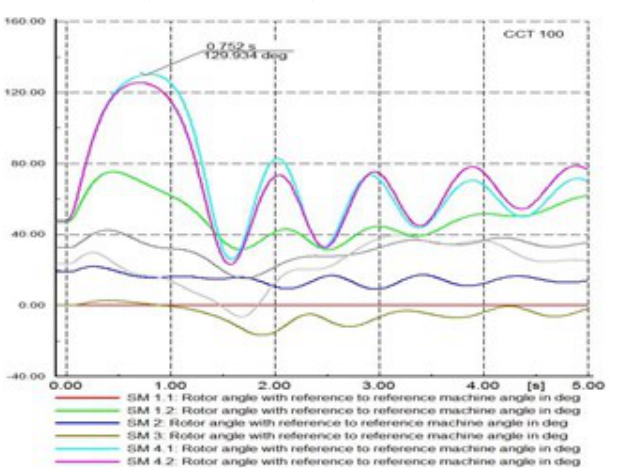
Fig. 9. Voltage Plot during fault on ‘Line 3_1’, cleared by switching off the line after 100ms. (Without HVDC line).